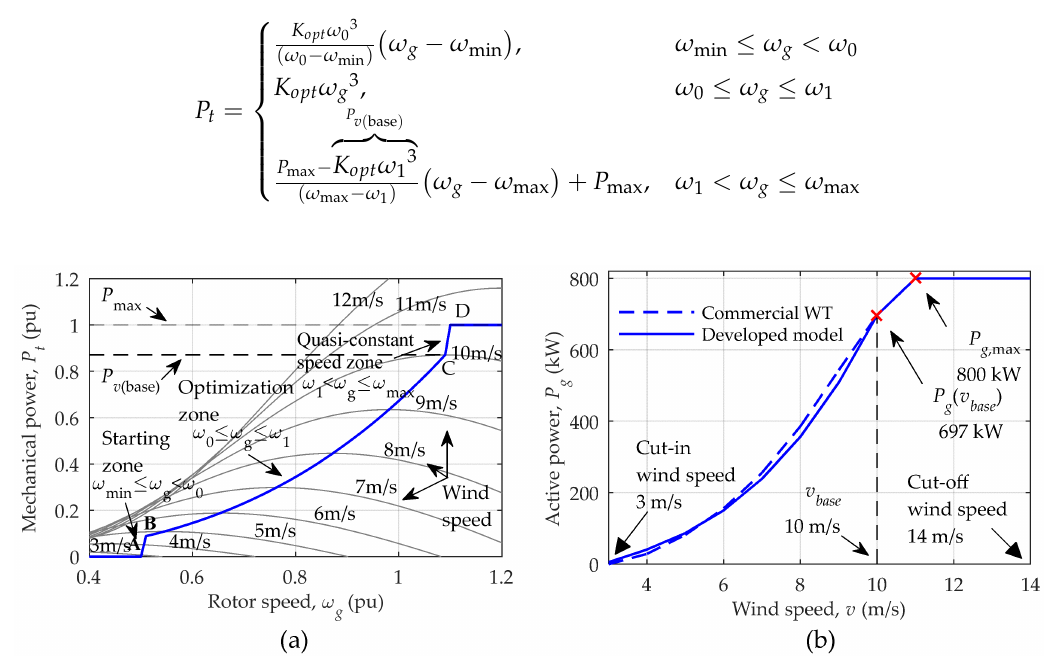
Figure 4. Wind turbine power curves: ( a ) ω -P chart; ( b ) Power-wind speed curve.